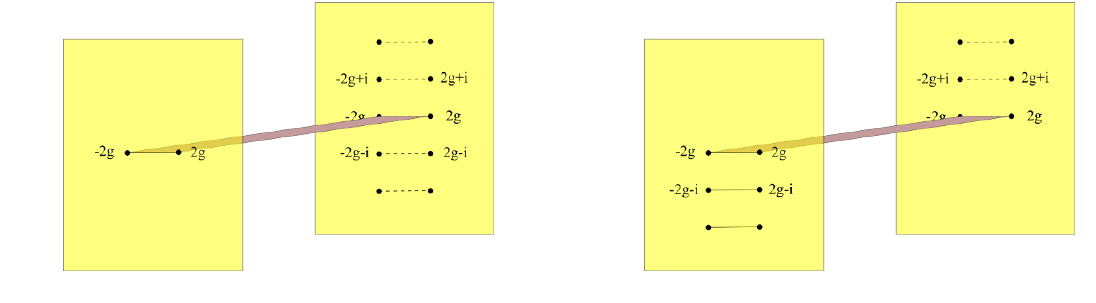
Figure 7 . Left : analytic structure of P a ( u ) and P a ( u ): P ( u ) has one cut on the (cid:12)rst sheet (left). Analytical continuation through this cut leads to the second sheet corresponding to ~ P ( u ) (right), which has an in(cid:12)nite ladder of cuts Right : analytic structure of Q i ( u ) and Q i ( u ): Q ( u ) has an in(cid:12)nite ladder of cuts in the lower half-plane (left). Analytical continuation through the cut on the real axis leads to a sheet corresponding to ~ Q ( u ), which has an in(cid:12)nite ladder of cuts in the upper half-plane